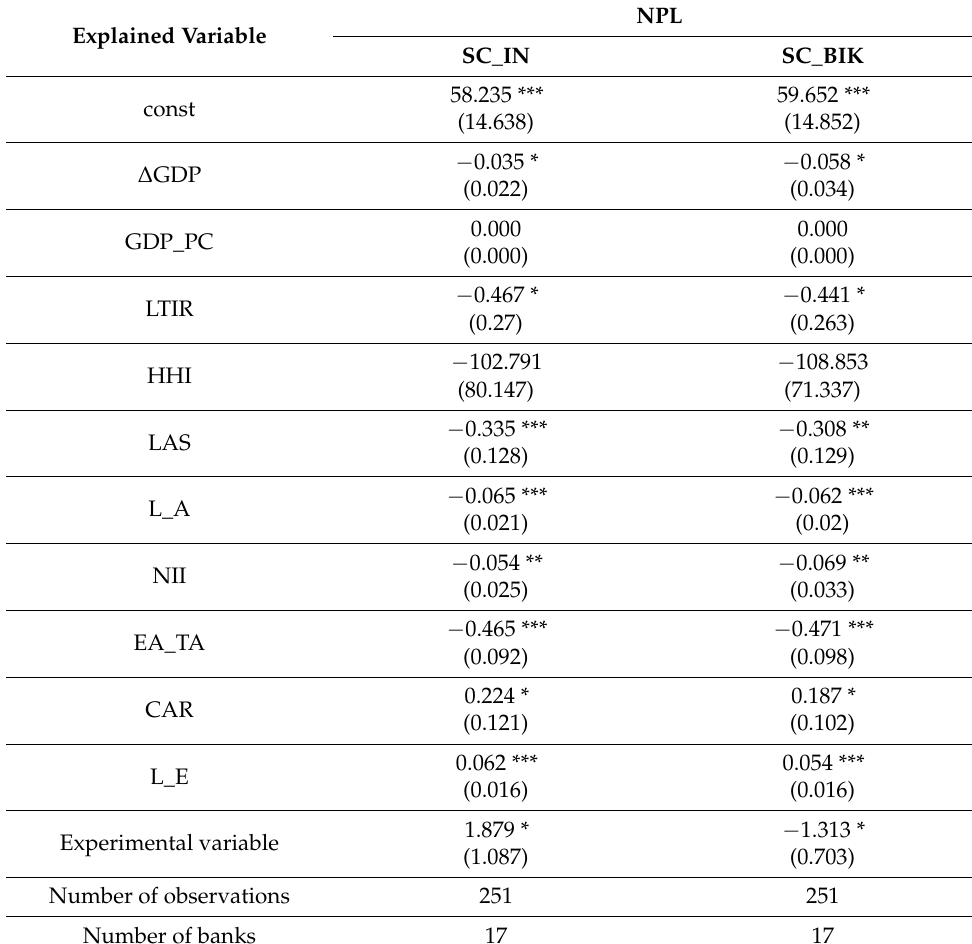
Table 5. The results of the panel study on the quality of the loan portfolio of BPS S.A. banks in the years